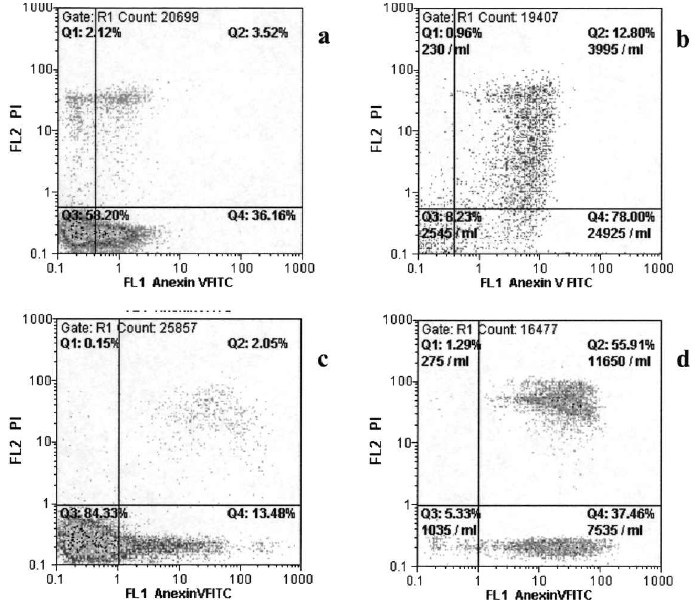
FIG. 3. Representative dotplots for cytofluorymetric method. Spontaneous and ConA stimulated (48h) apoptosis of MNC in an allergic patient (a and b panels); spontaneous and ConA(48h) stimulated apoptosis in non-allergic subject (c and d